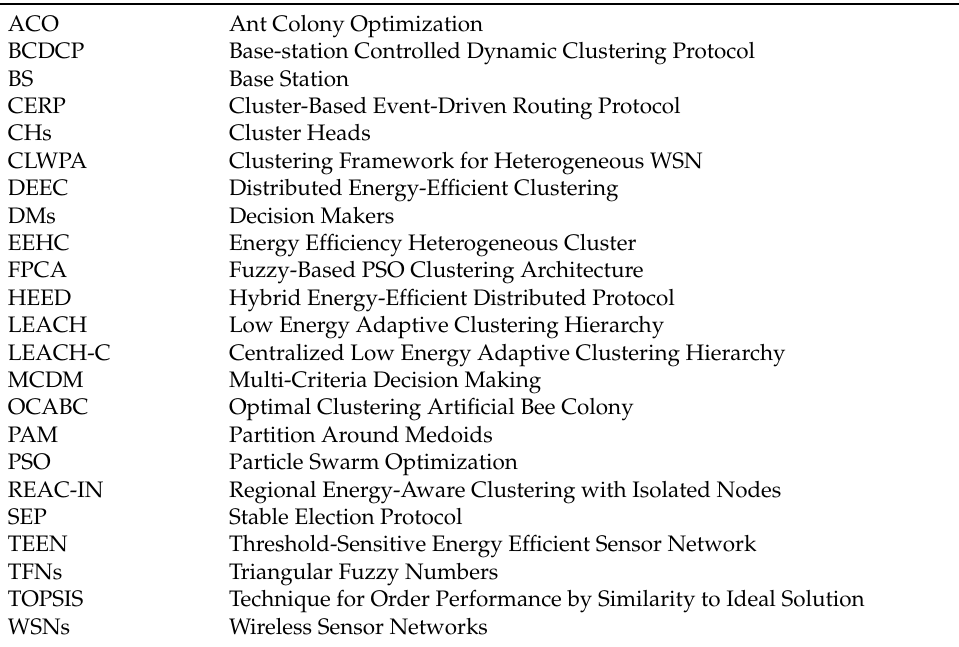
Table 1. List of